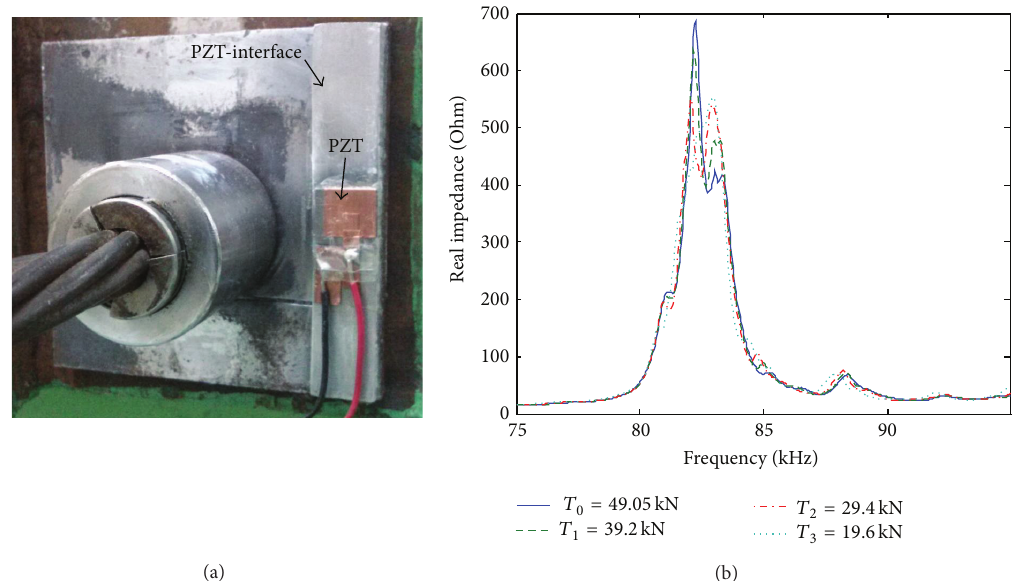
Figure 1: Prestress-loss monitoring using PZT-interface [13]: (a) mountable PZT-interface and (b) impedance signatures for prestress